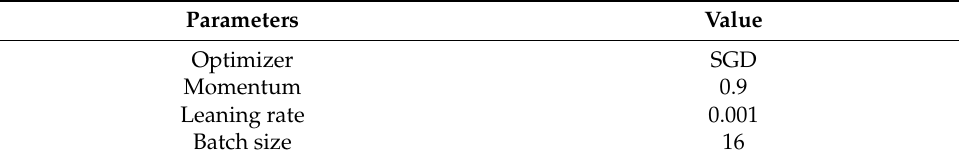
Table 4. Hyper-parameters of model experiments.